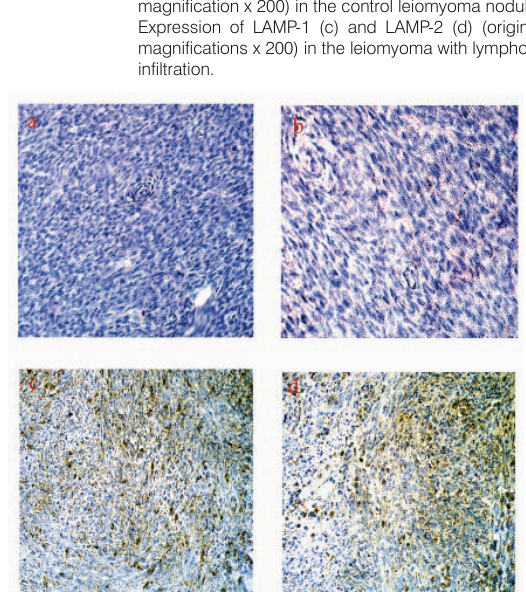
Figure 4. Immunohistochemistry. Expression of LAMP-1 (a) (original magnification x 100) and LAMP-2 (b) (original magnification x 200) in the control leiomyoma nodule. Expression of LAMP-1 (c) and LAMP-2 (d) (original magnifications x 200) in the leiomyoma with lymphoid